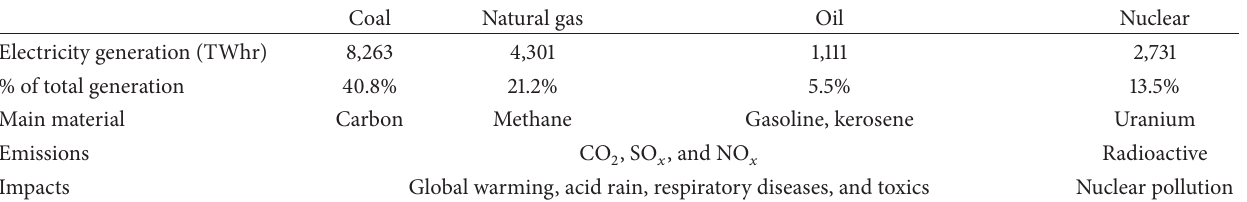
Table 1: Comparison of different traditional power plants (2009).